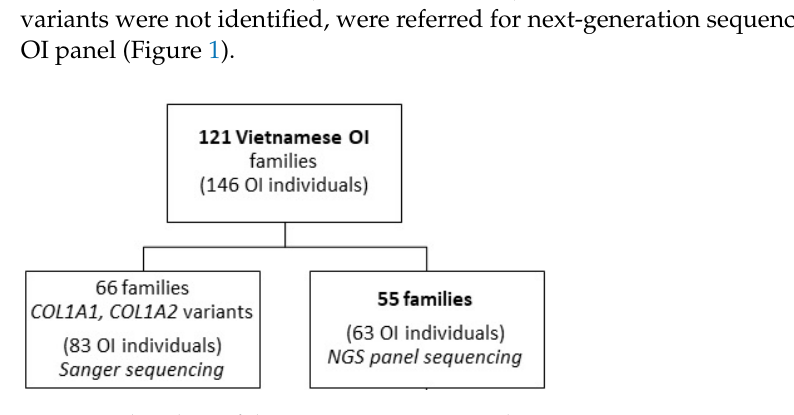
Figure 1. Flowchart of the Sanger sequencing and next-generation sequencing (NGS) analysis of the Osteogenesis Imperfecta (OI) Vietnamese families.